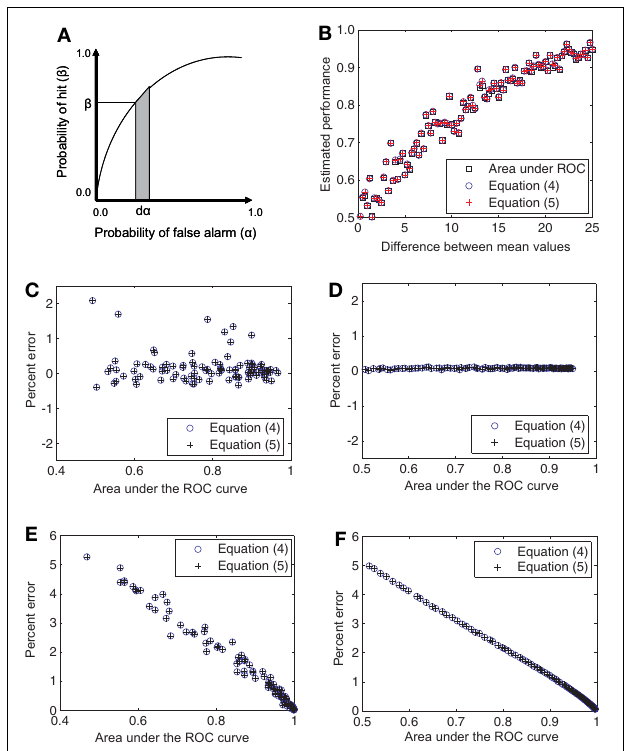
FIGURE 1 | Relationship of the derived estimators to the area under (cid:7) β d α has the equivalent the ROC curve. (A) Area under the ROC curve definitions given Equations (2) and (3) and admits the estimators given in Equations (4) and (5). (B) Single estimates of the area under the ROC curve and Equations (4) and (5) are shown comparatively for a progressively increasing difference in the mean firing rates for Gaussian distributions. The points are predominantly coincident. (C) The percent error for single estimates lies within 2%. (D) When 100 such trial estimates are averaged together, the percent error falls close to 0%. These differences in the estimates are not systematic and are entirely due to numerical errors. (E,F) Same as (C,D) but for Poisson distributions. In this case the errors decrease monotonically from about 5 to close to 0%.